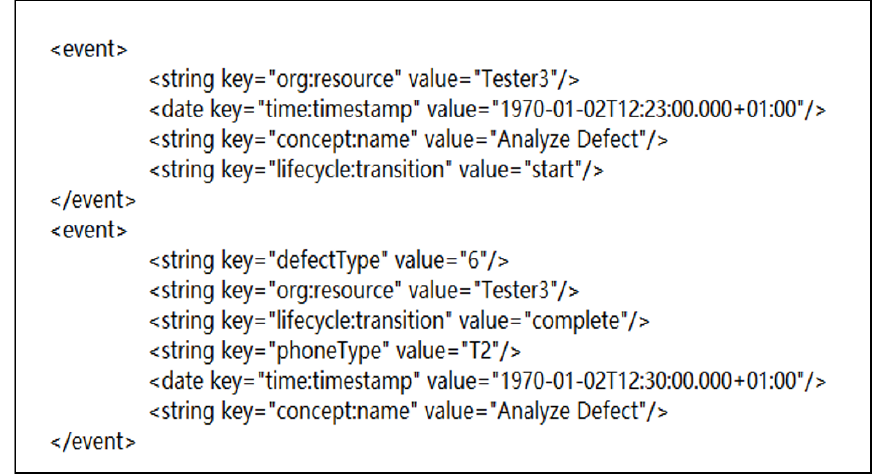
Figure 12. A specific “Analyze Defect” activity information in a service instance.